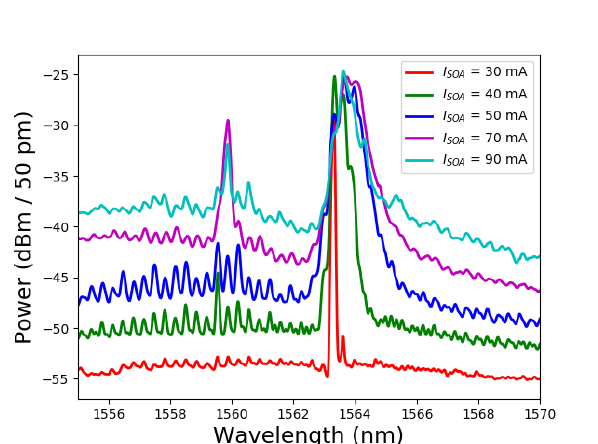
Figure 8. Observed ASE broadening caused by narrow longitudinal mode spacing of external laser cavity. The PhC lattice constant in this case is